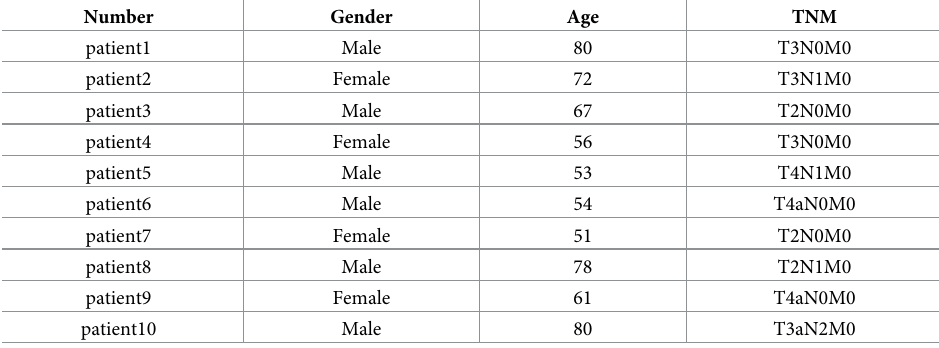
Table 1. Demographic and clinical characteristics of the